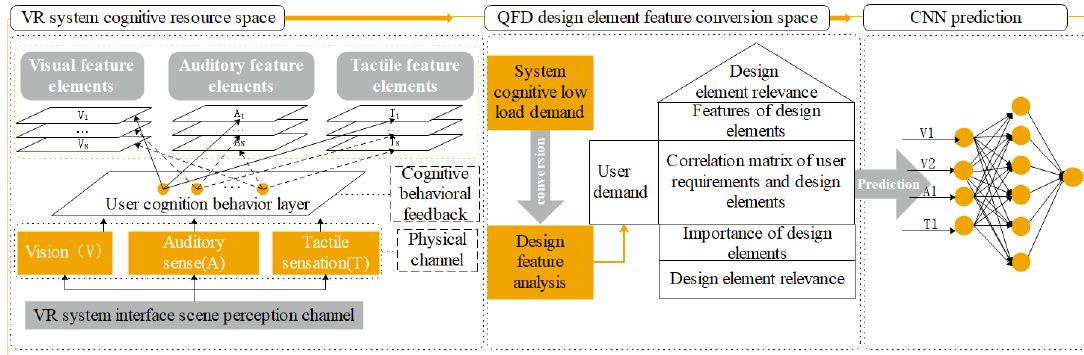
Figure 1. Theoretical framework.